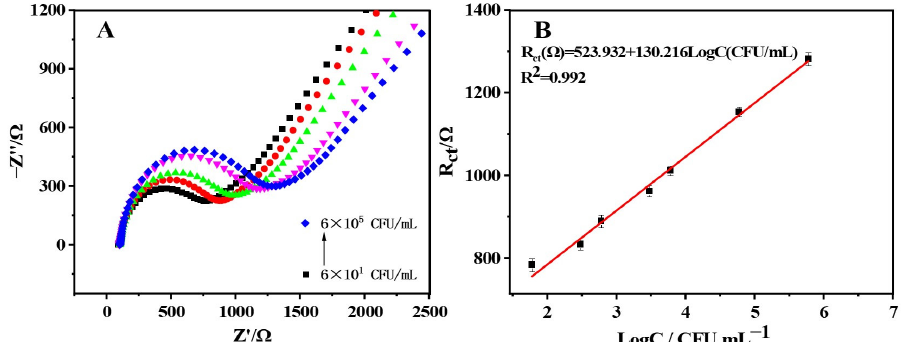
Figure 4. ( A ) Nyquist diagram of SE at different concentrations. ( B ) The relationship between the logarithmic value of concentration and the electron transfer impedance.